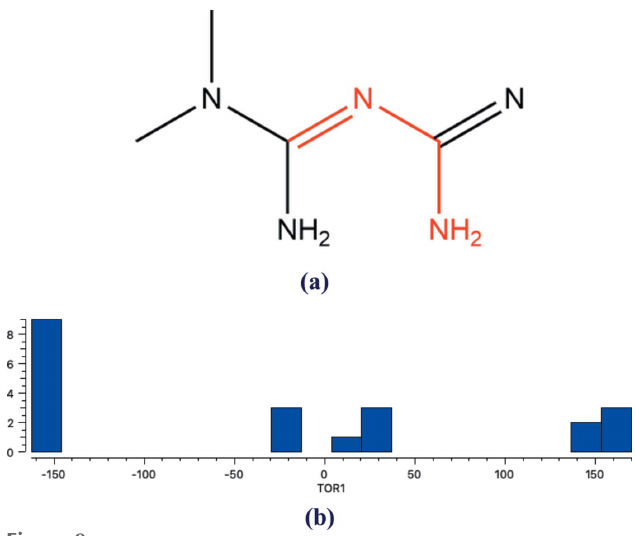
Figure 9 ( a ) Fragment used for search in Cambridge Structural Database, ( b ) histogram of torsion angle TOR1 [shown in red in ( a )].